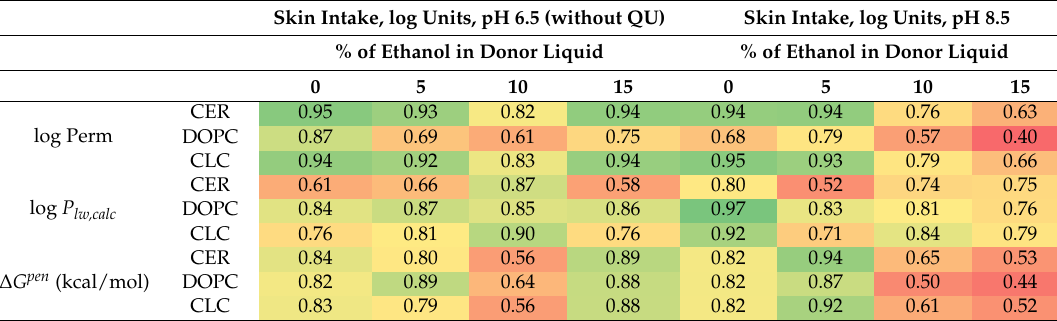
Table A7. Correlation coefficients (r 2 ) between skin intake and calculated permeability (log Perm ), lipid/water partition coefficient (log P lw,calc ) and penetration barrier ( ∆ G pen ) in membrane